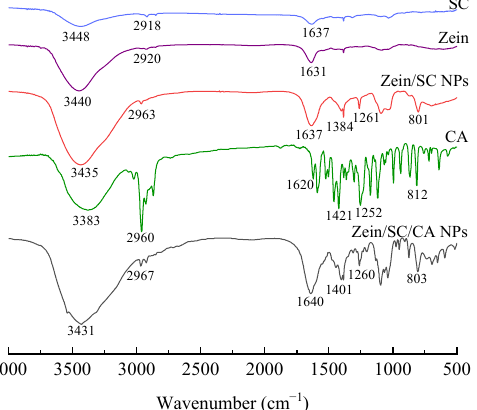
Figure 1. FT-IR image of SC, zein, zein/SC composite NPs, CA, and zein/SC/CA composite NPs.